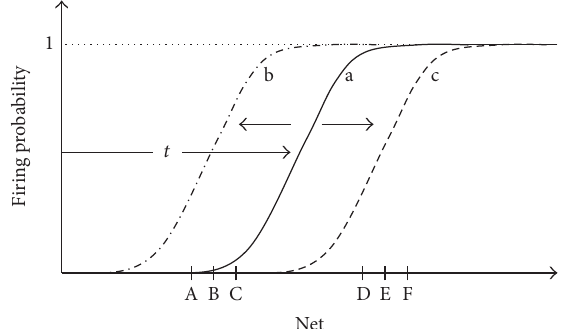
Figure 2: Intrinsic plasticity is the property of real neurons that allows the neuron’s sigmoidal activation function to shift either leftwards or rightwards, so that the sigmoid is placed over intervals corresponding to the average net input of the neuron. (a) Initial position of the sigmoidal activation function. (b) If the values of net inputs of the neuron are low (as in case of inputs A, B, and C), the activation function shifts leftwards. (c) If net input values are high (as in D, E, and F), the sigmoid gradually shifts